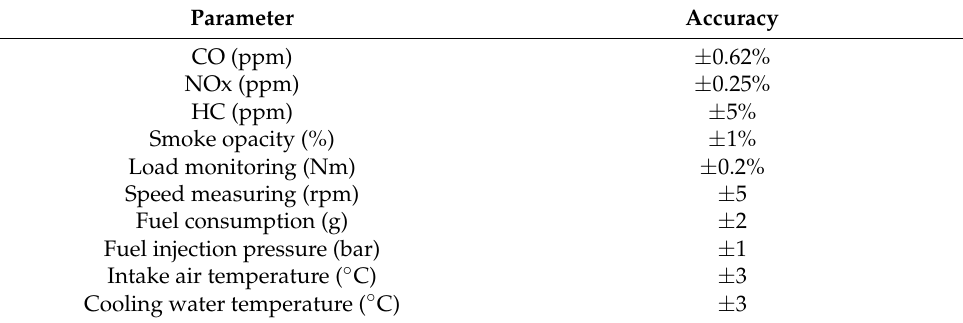
Table 4. Specifications of exhaust emission device and measurement